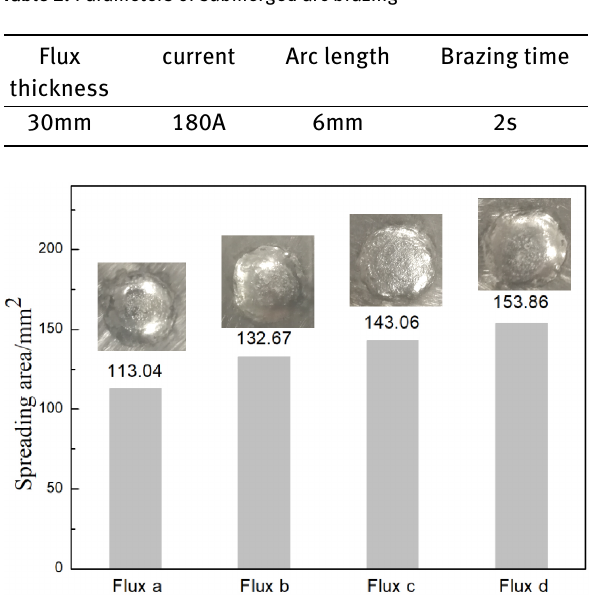
Table 2: Parameters of submerged arc brazing